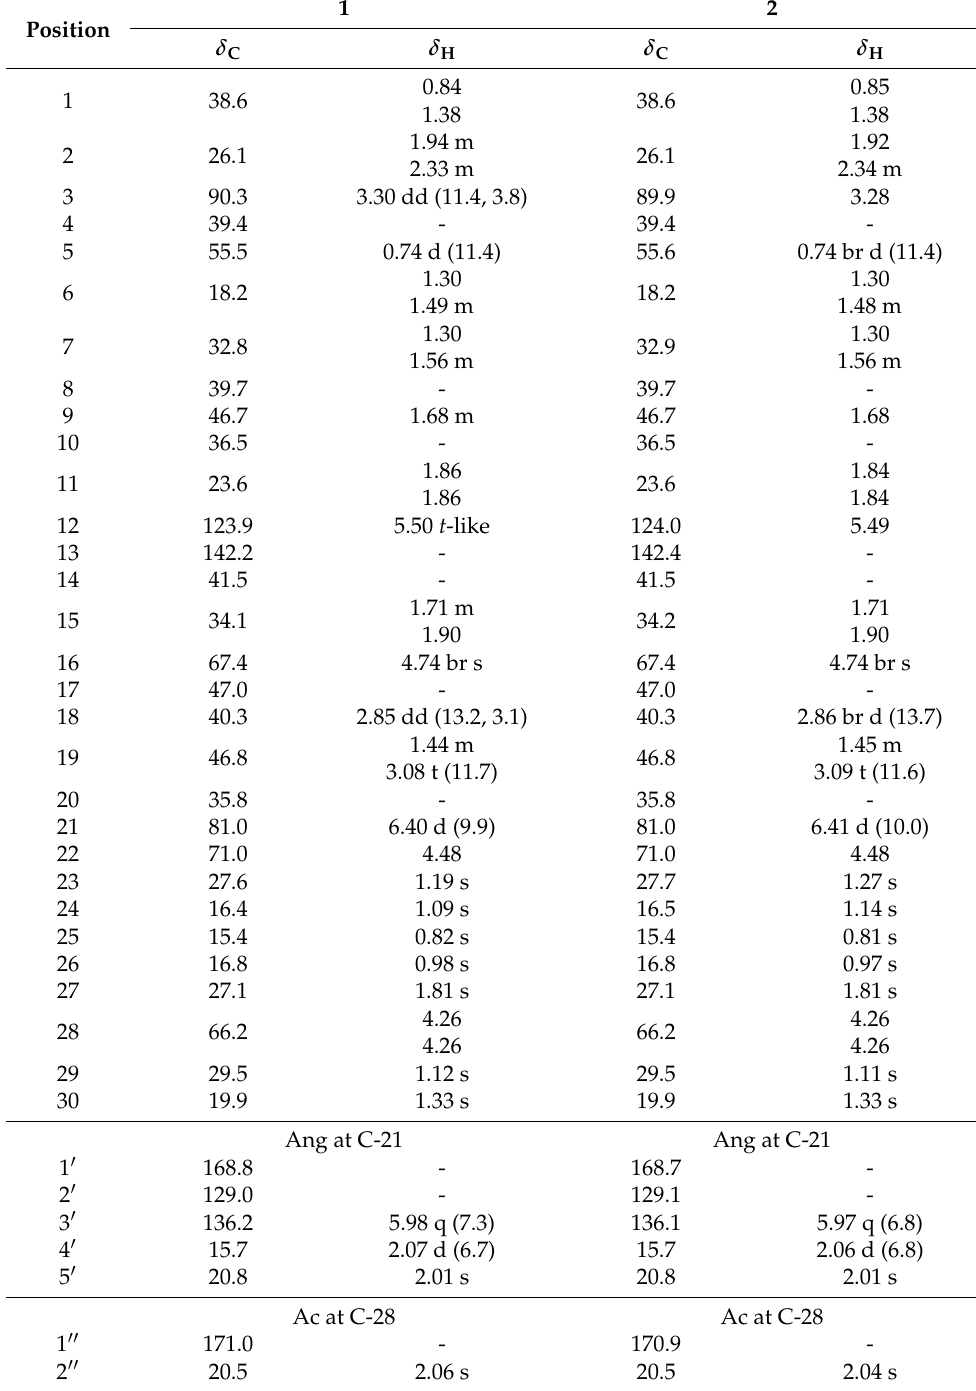
Table 1. 1 H (600 MHz) and 13 C (150 MHz) NMR data of the aglycone moieties of compounds 1 and 2 in pyridine- d 5 ( δ in ppm, J in parentheses in Hz) a